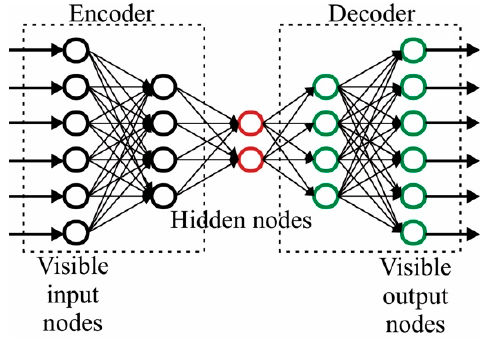
Figure 9. Autoencoder structure.